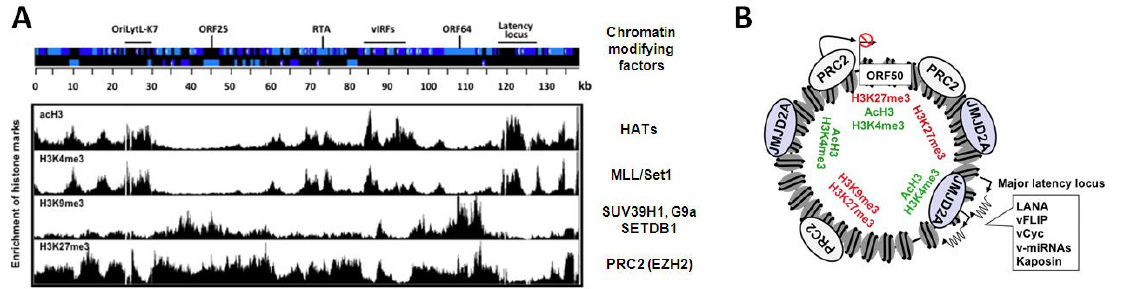
Figure 3. The chromatin landscape of KSHV during latency. ( A ) Schematic of the KSHV genome and the genome-wide distribution of different histone marks along the viral genome. There are distinct chromatin domains on the viral episome, which are characterized by different histone modification patterns indicating the targeted recruitment of specific cellular chromatin modifying enzyme complexes to different sites of the viral genome. The cellular chromatin modifying factors associated with each histone mark are listed to the right. The position of the latency locus and examples of an IE gene (RTA), some early genes (viral interferon regulatory factors or vIRFs and the OriLytL-K7 locus) and L genes (ORF25 and ORF64) are indicated at the top; ( B ) The PRC2 complex co-localizes with H3K27me3-rich chromatin domains, while the binding of the H3K9me3 histone demethylase JMJD2A overlaps with the H3K4me3/acH3-enriched chromatin regions that have a low level of H3K9me3. PRC2 is involved in the inhibition of ORF50 (RTA) expression during